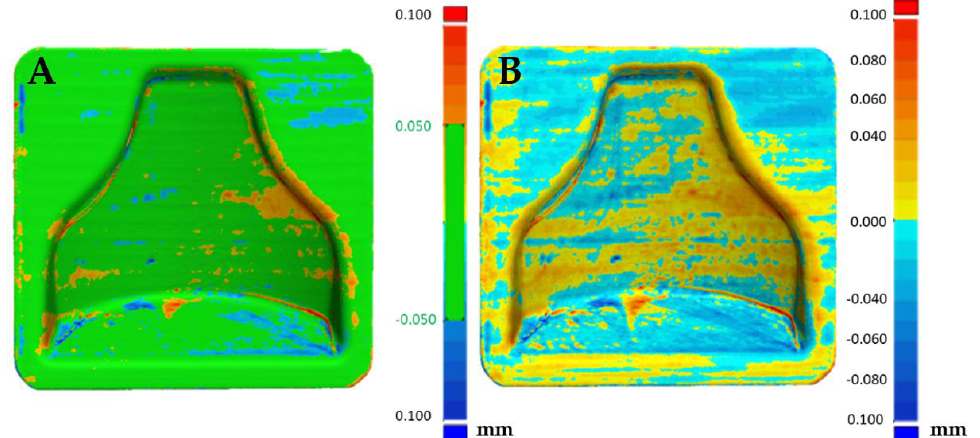
Figure 15. Comparison between the two molds (mold 1 ( A ), mold 2 ( B )) after smoothing.